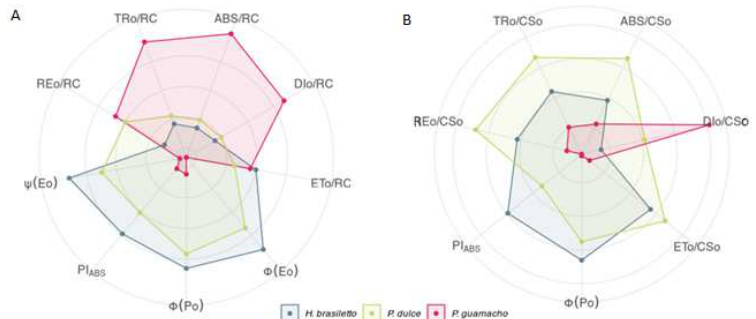
Figure 1. Spider-plot showing various parameters obtained from the rapid emission phase of chlorophyll a fluorescence in H. brasiletto, P. dulce , and P. guamacho . Each line represents the average of 7 plants. ( A ) Specific energy flux parameters (ABS/RC, DIo/RC, Tro/RC, Eto/RC, and REo/RC), quantum efficiencies ( Φ Po , Φ Eo , and Ψ o ), and performance index (PI ABS ). ( B ) Phenomenological energy flux parameters (ABS/CSo, Dio/Cso, Tro/Cso, Eto/Cso, and REo/CSo). Table 2. Parameters obtained from the rapid emission phase of chlorophyll a fluorescence. Variable